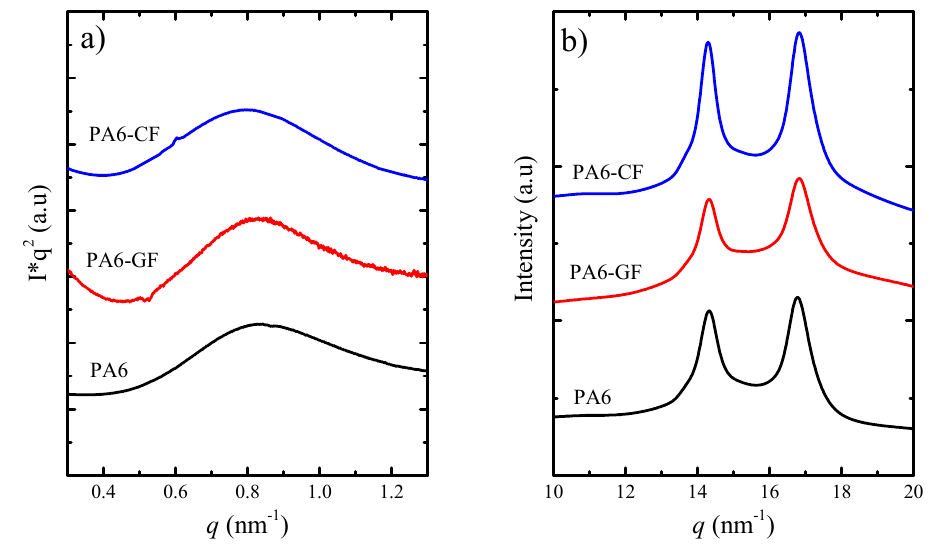
Figure 5. ( a ) SAXS (Small Angle X-ray Scattering) patterns taken at all the PA6 samples as obtained. ( b ) WAXS (Wide Angle X-ray Scattering) diffractograms taken at the same conditions.